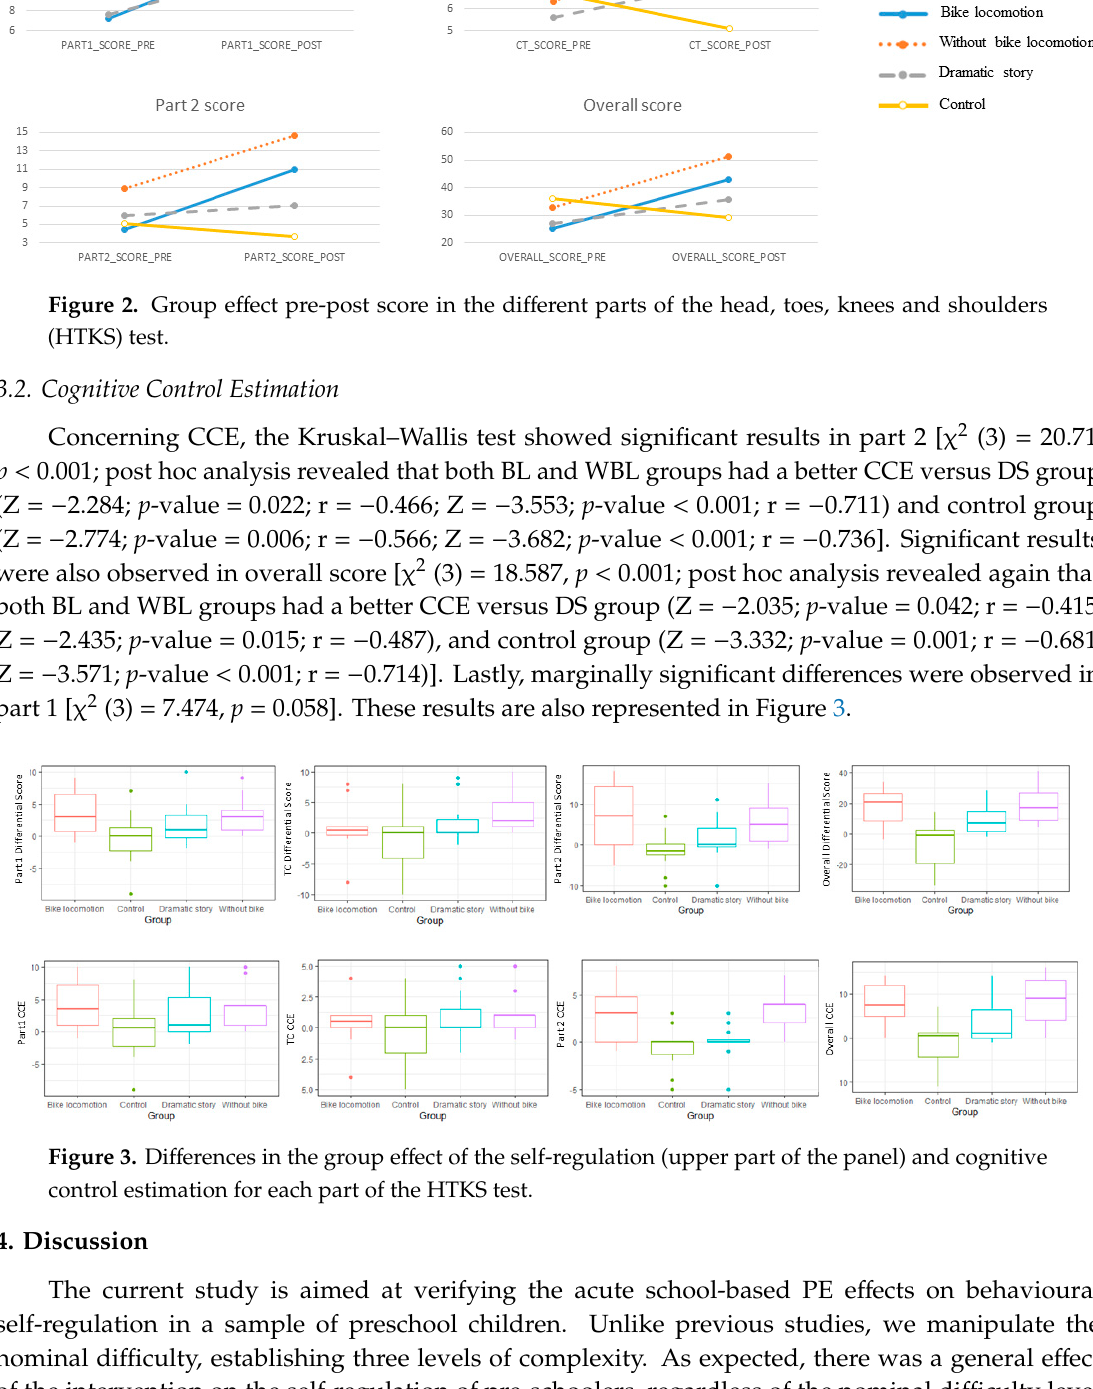
Figure 3. Differences in the group effect of the self-regulation (upper part of the panel) and cognitive control estimation for each part of the HTKS test.